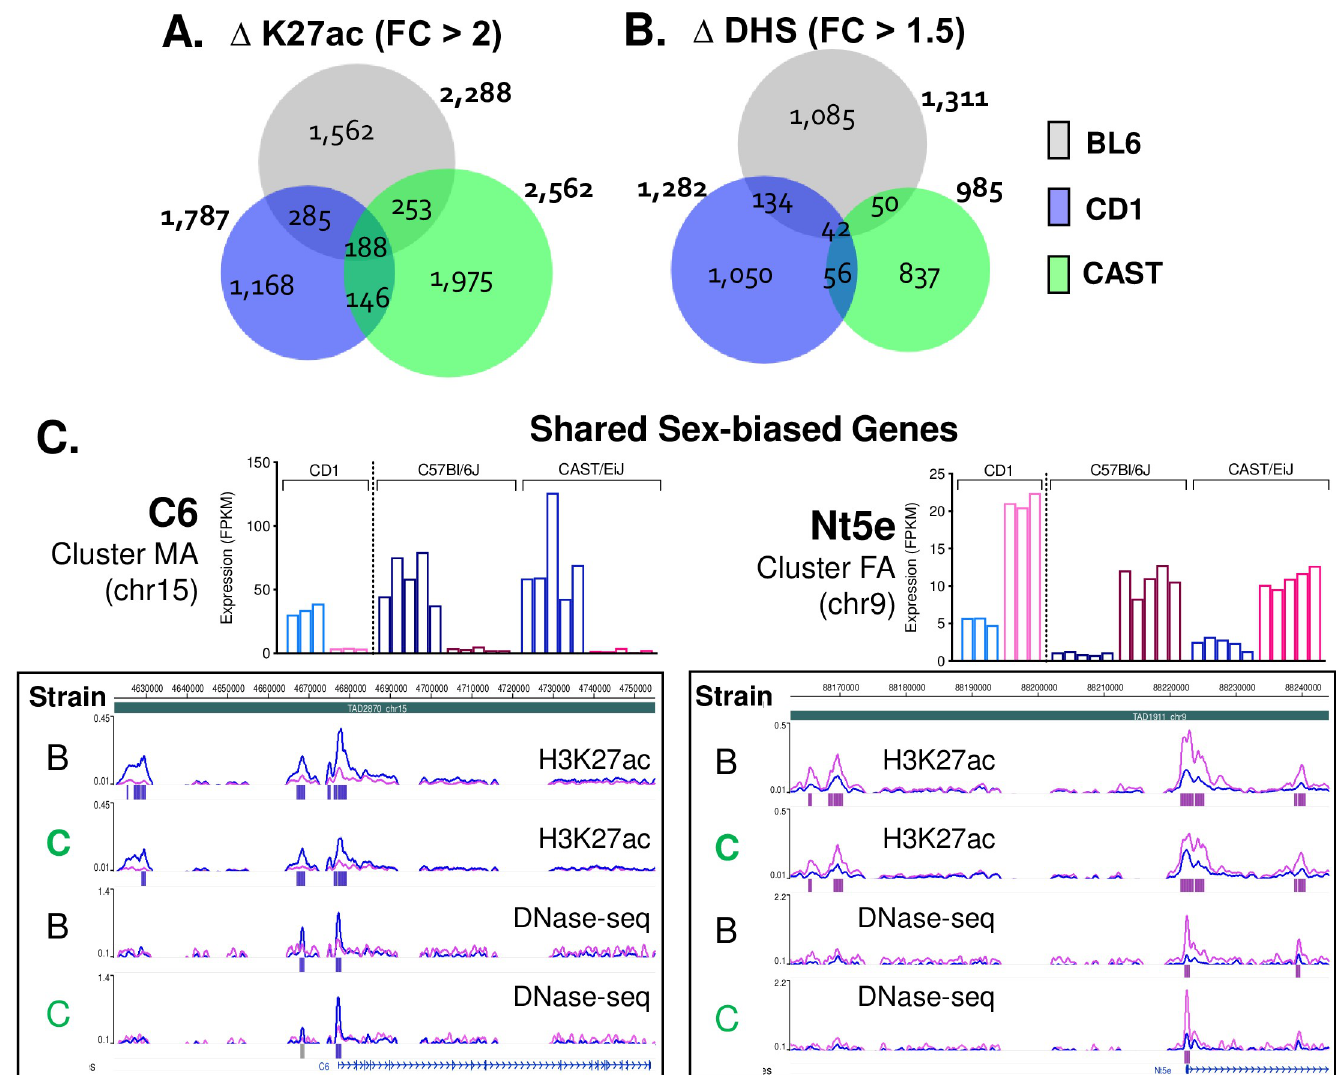
Fig 2. Shared sex-biased enhancers. A, B. Venn diagrams showing the number of sex-biased H3K27ac peaks ( Δ K27ac) ( > 2-fold sex difference at FDR < 0.05, based on diffReps) or sex-biased DHS ( Δ DHS) ( > 1.5-fold sex difference at FDR < 0.05, by diffReps) based on peak overlap by at least 1 bp. Data for CD-1 Δ K27ac peaks was provided by Dr. Dana Lau-Corona of this lab. CD-1 Δ DHS peaks were the robust sex-differential DHS dataset from [119]. C. Genes from clusters MA and FA (Fig 1A) with matching sex-biased cis regulatory elements in both strains. C6 is a male-biased gene with male-biased H3K27ac marks and male-biased DHS at the proximal promoter and upstream enhancers. Nt5e is a female-biased gene with female-biased H3K27ac marks and female-biased DHS at both the proximal promoter and two neighboring enhancers. Bar graphs above the screenshots: RNA expression levels (FPKM) in individual male (blue bars) and female (pink bars) CD-1, B6, and CAST livers. Uniform expression across strains is observed, as expected for genes in clusters MA and FA. See Sheet A in S1 Table for full list of expression values.